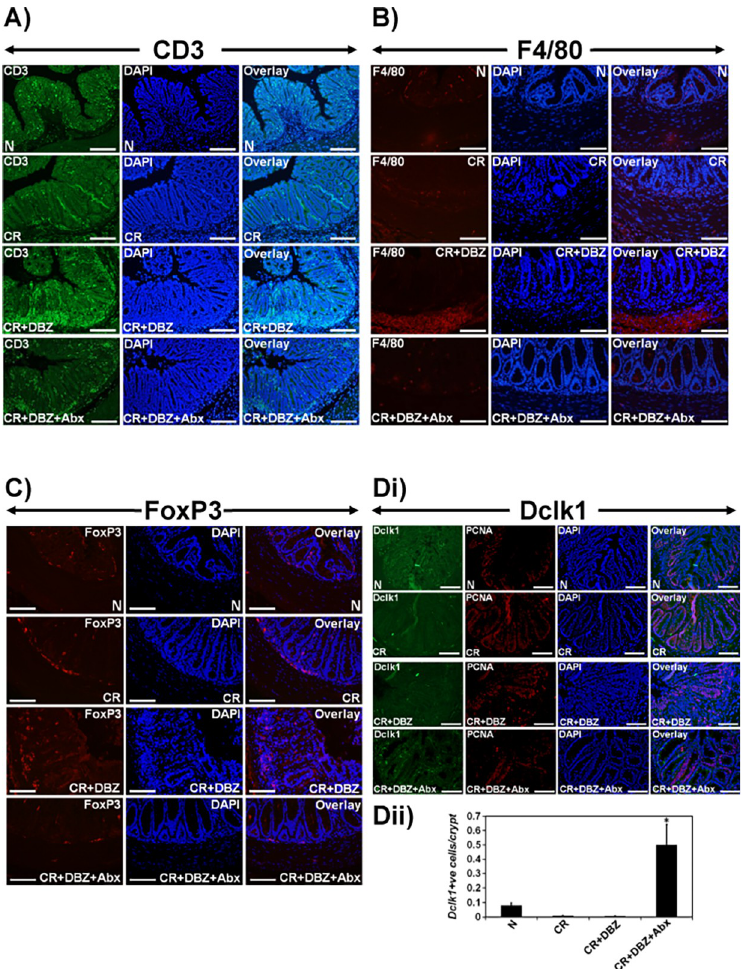
Fig 6. Effect of antibiotics treatment on immune cell recruitment and ISC marker expression. A-D. Representative immuno-staining for CD3 (A), F4/80 (B), FoxP3 (C) and Dclk1 (Di) in the colon sections prepared from the indicated groups. Bar = 100 μ m; n = 3 independent experiments). Dii. Quantitative assessment of Dclk1+ cells/crypt; � p < 0.05; n = 3 independent